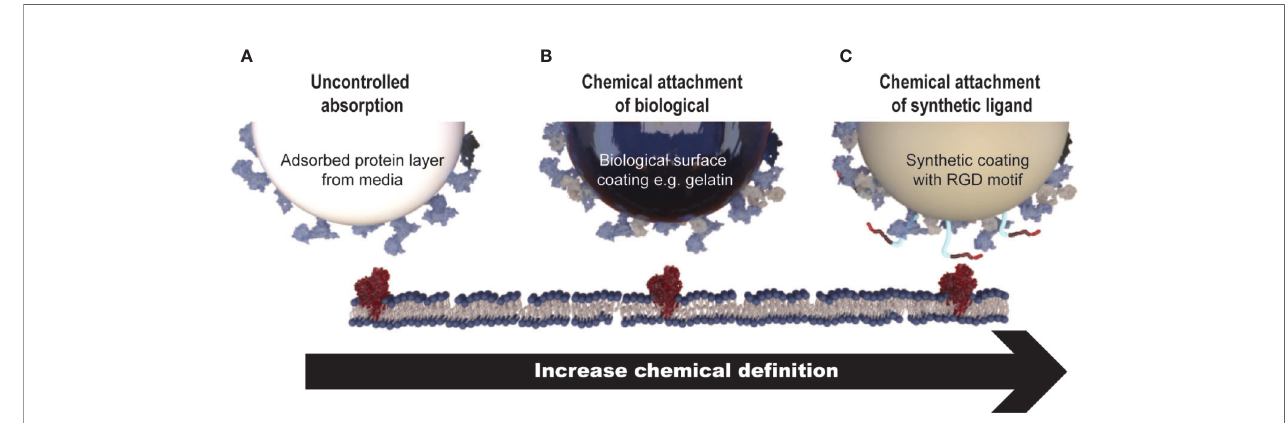
FIGURE 3 | Mechanisms of MSC attachment to microcarriers. (A) Cell attachment is facilitated through non-speci fi c protein adsorption on the surface of microcarriers that do not contain a coating of any description (e.g., Solohill Plastic). (B) Microcarriers that contain a coating of a biologically derived molecule (e.g.,